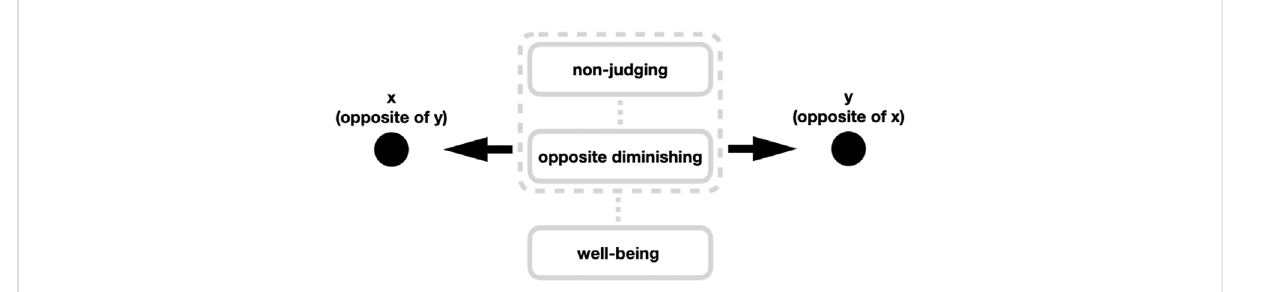
FIGURE 1 Opposite diminishing is proposed to be a mental realm where one is neither mentally drawn to thinking in terms of one opposite pole of pair of opposites (such as “ this is good ” , “ I like this, ” etc.) nor is mentally drawn to thinking in terms of the other opposite pole of the same pair of opposites (such as “ this is bad ” , “ I don ’ t like this, ” etc.). Rather it is a mental realm in which one is located exterior ( “ between ” , “ beyond ” ) to either side of the opposite poles. Such a mental state is proposed to be associated with non-judging, and both of these mental conditions (opposite diminishing and non-judging) are proposed to be associated with mental